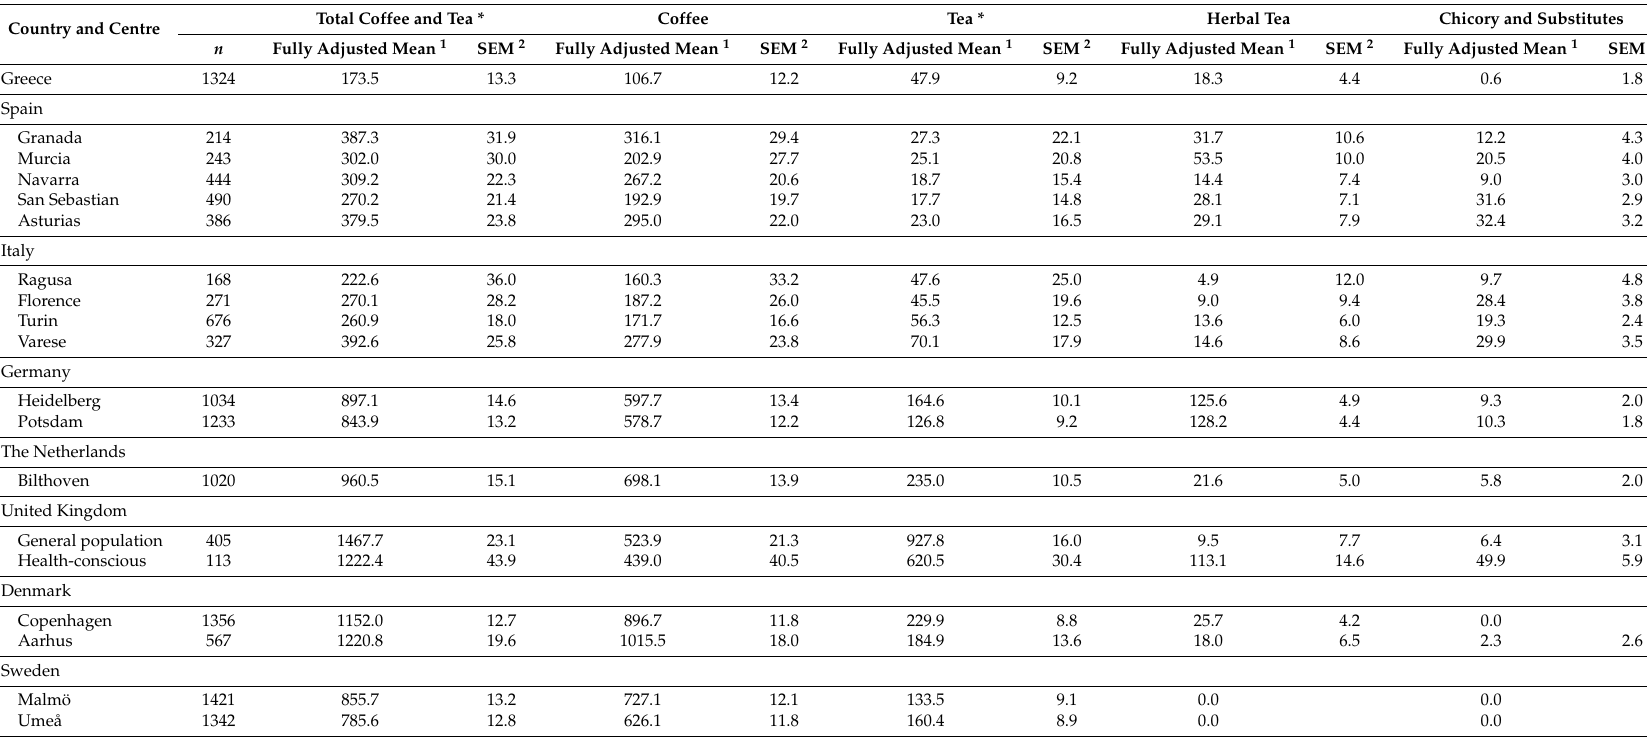
Table 1. Mean daily intake of coffee and tea (g/day) by type in the EPIC calibration study population based on 24-H Dietary Recall among men across EPIC centres ordered from south to